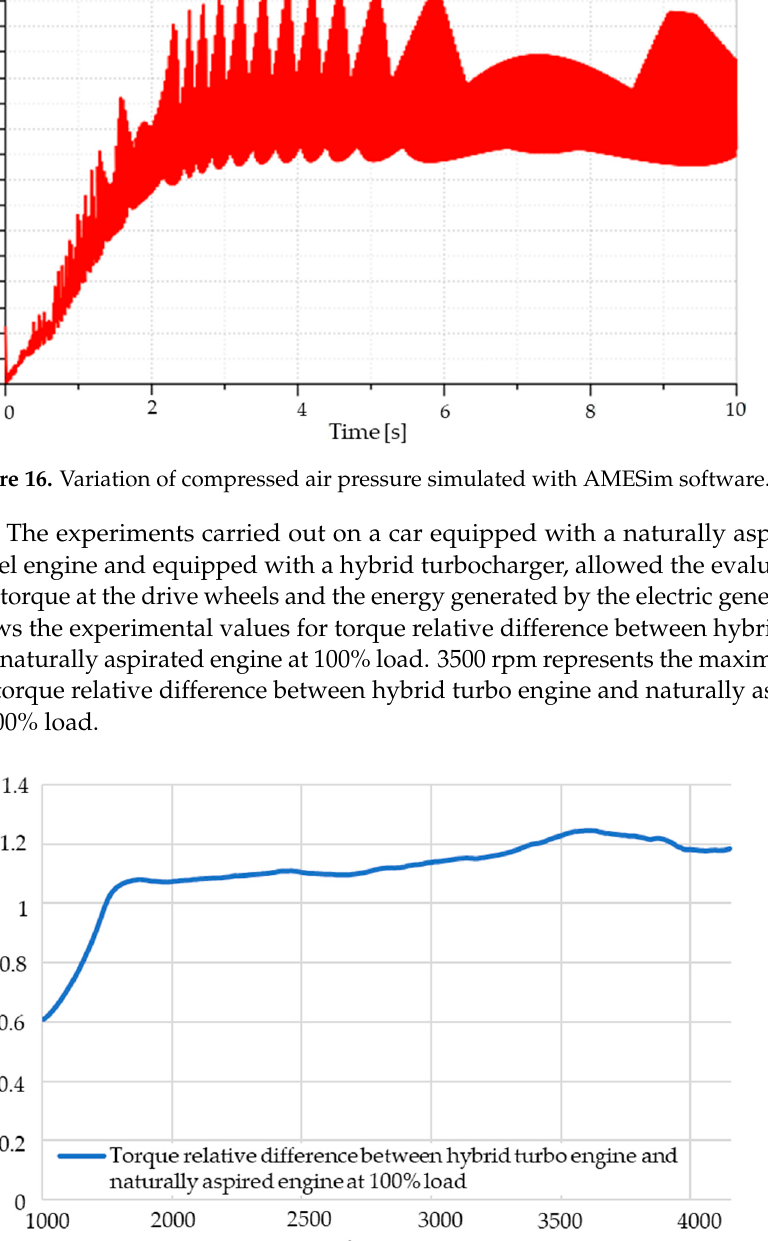
Figure 17. Experimental values for torque relative difference between hybrid turbo engine and naturally aspired engine at 100% load.